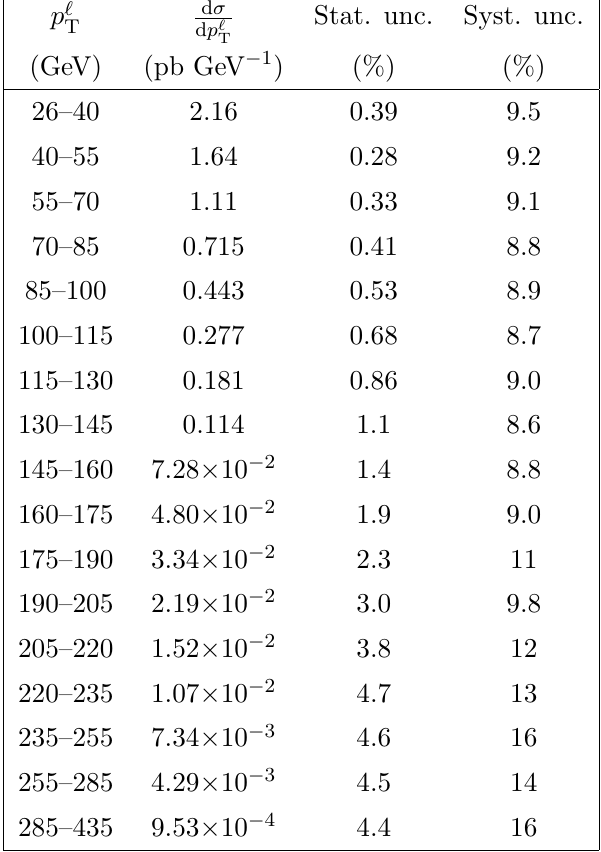
Table 16 . Results of the absolute di(cid:11)erential cross sections with relative uncertainties in the combined channel with respect to p ‘ T